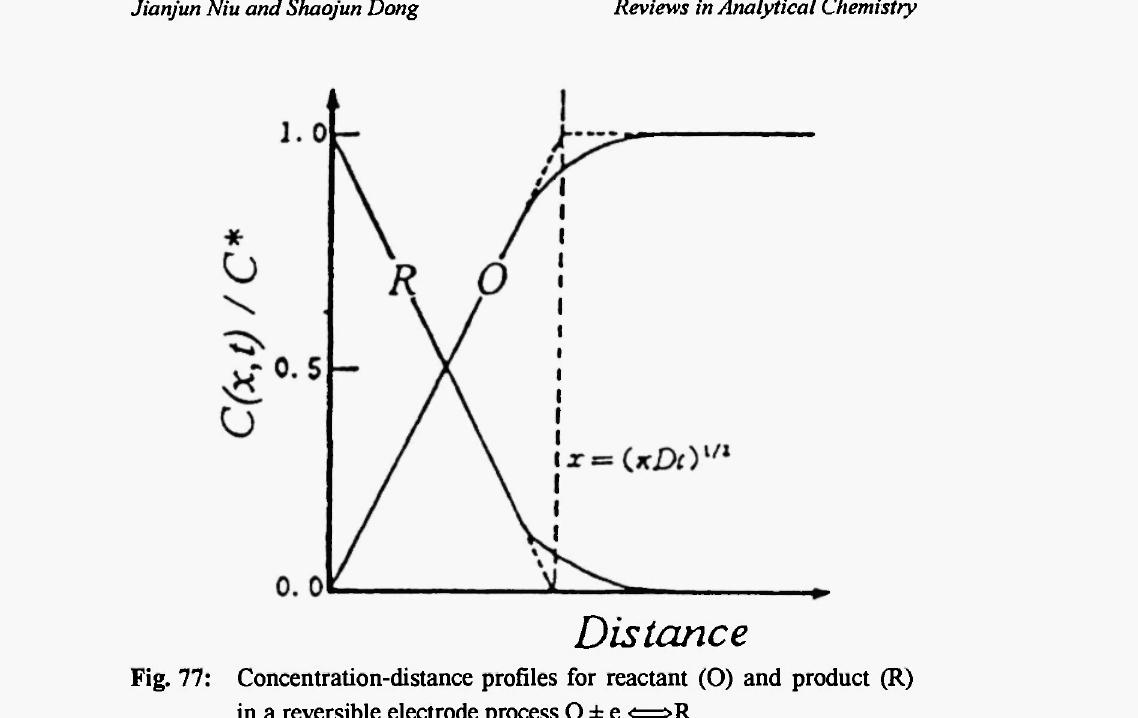
Fig. 77: Concentration-distance profiles for reactant (O) and product (R) in a reversible electrode process Ο ± e <=>R.